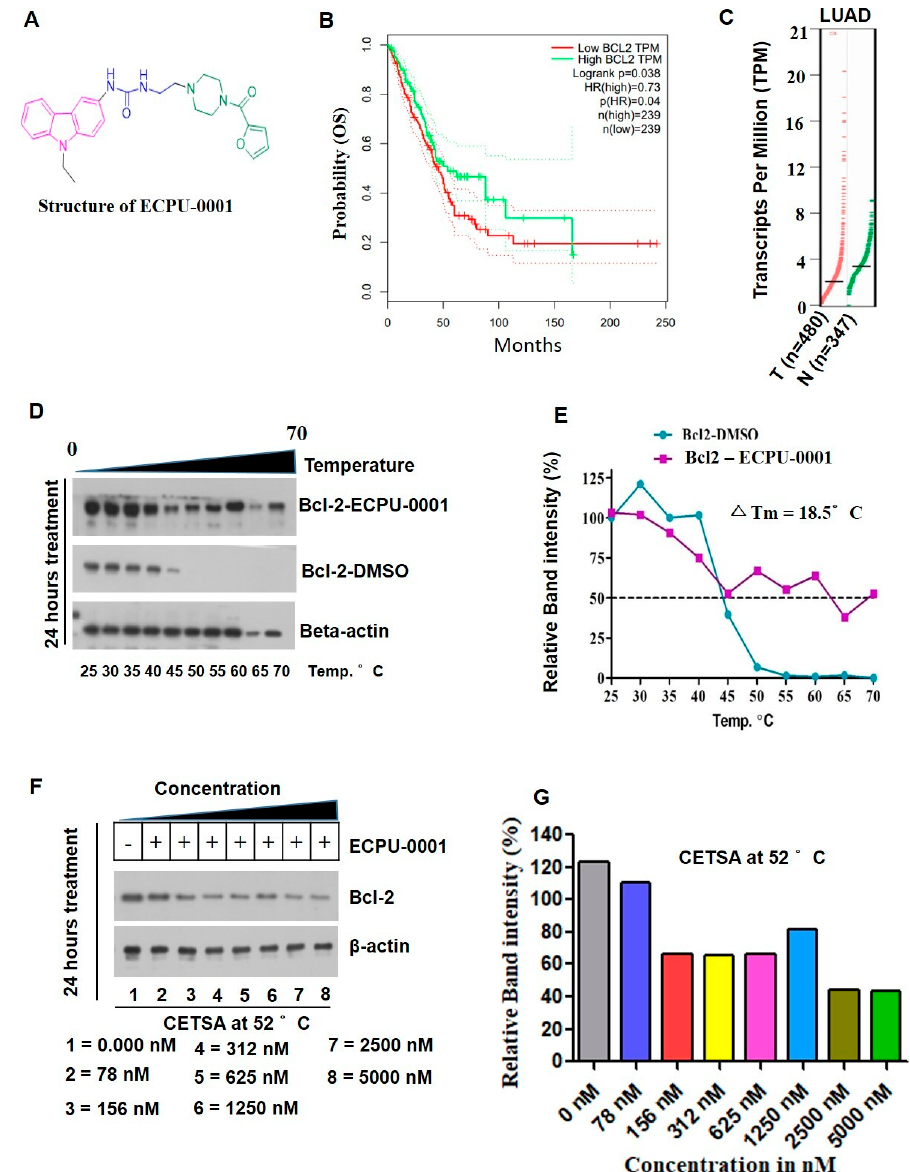
Figure 3. ECPU-0001 strongly interacts with BCL-2 in vitro. ( A ) Structure of novel hybrid molecule ECPU-0001. ( B ) Kaplan Meier survival curve showed overexpression of BCL-2 affect patient’s survival in adeno carcinoma of lung patients. Patient’s survival analyzed and obtained from GEPIA online web portal. ( C ) Scatter plot showed an elevated mRNA levels of BCL-2 in adenolung cancer patient’s samples compared with normal lung tissue which is derived from GEPIA analysis. ( D ) The cellular thermal shift assay (CETSA) was performed to evaluate the engagement and interaction between ECPU-0001 and BCL-2 in cell lysates (in vitro). After incubation with a compound ECPU-0001 (2.0 µM) or a vehicle control (DMSO), cells were subjected to aliquot then heated in ten different temperatures (from 25 °C to 70 °C). Subsequently, an aggregated proteins precipitation is spin downed by centrifugation at 3000 rpm speed for 2 min. The rest of soluble protein lysate is examined by immunoblotting. ( E ) Relative band intensity percentage was calculated using ImageJ software and determined Δ Tm value. ( F ) Further, to determine the inhibitory dose of ECPU-0001 to reduce the translation of BCL-2, 2 µM of ECPU-0001 treated to lung cancer cells and then performed isothermal cellular engagement assay using Isothermal CETSA. ( G ) BCL-2 protein relative expression in terms of band intensity was calculated using ImageJ software.